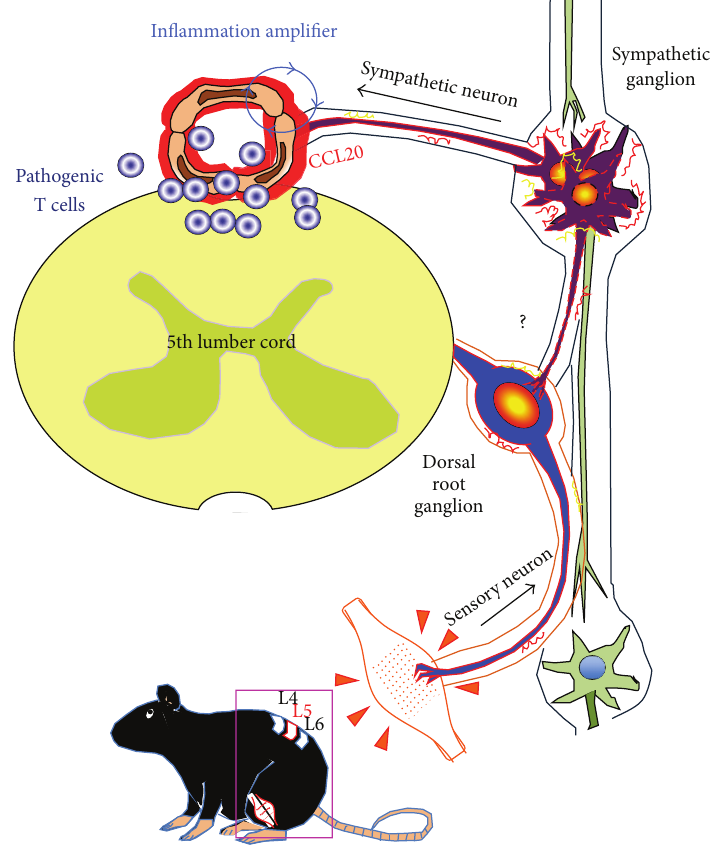
Figure 5: Schematic representation of neural stimulation-mediated activation of the inflammatory amplifier. Neural signals from the soleus musclescausedbygravitationalstimulationreachetheL5dorsalrootganglion.Subsequentactivationofsympatheticnervesaltersthestatusof endothelial cells in L5 dorsal venules to enhance the inflammation amplifier, which leads to the production of chemokines including CCL20. Norepinephrine acts as a mediator between the neural signal and activation of the inflammation amplifier. The neural network determining communication between soleus muscle-derived sensory neurons and sympathetic neurons that reach L5 is not currently defined (depicted with a question